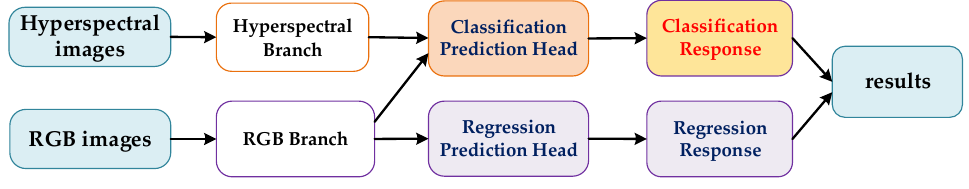
Figure 1. The flowchart of the RANet. In this flowchart, the input is hyperspectral and RGB images, and the output is the prediction result of the object